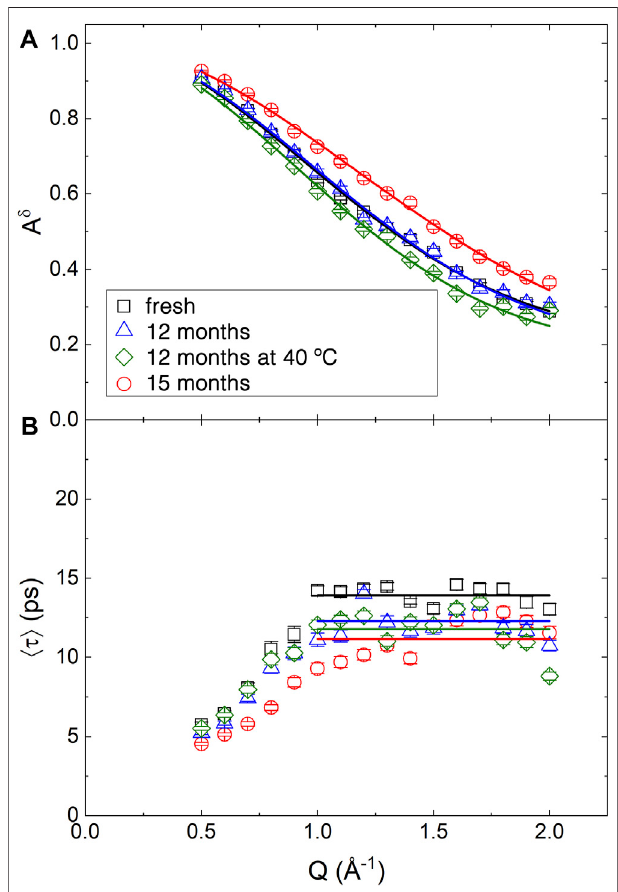
FIGURE 6 | Q dependence of the best fi tting parameters obtained from the QENS spectra of BCO at four aging stages using Eq. 20 . (A) Continuous linesarethe fi ttingaccordingto Eq.21 . (B) Straightlinesindicatetheexpected plateau value of 〈 τ 〉 for Q ≥ 1 Å − 1 .